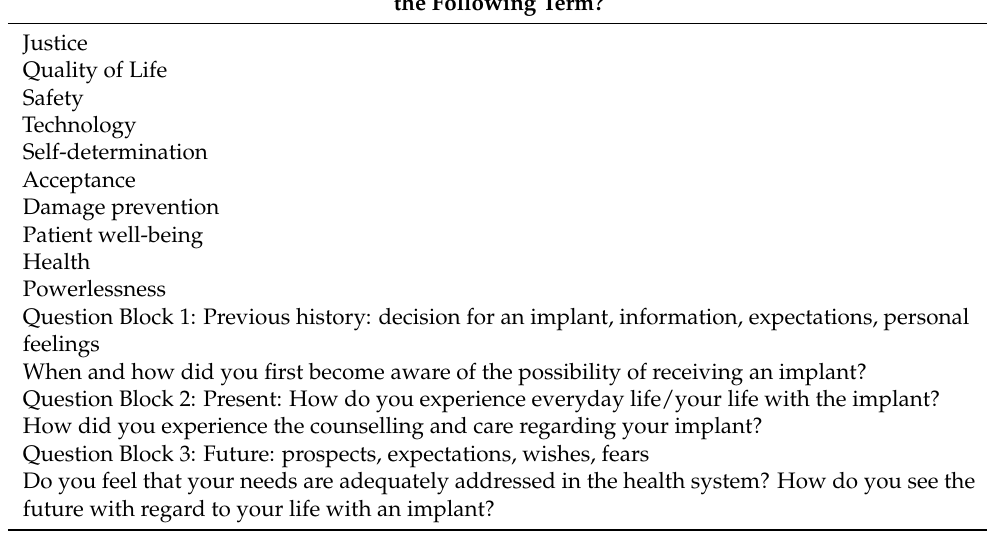
Table A1. Group discussion: adapted to each implant type.